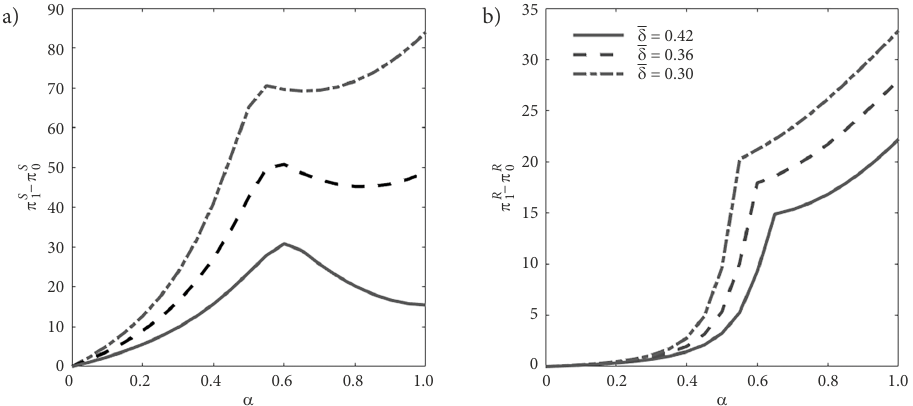
Figure 5. Impact of factor’s pricing ability for any division of